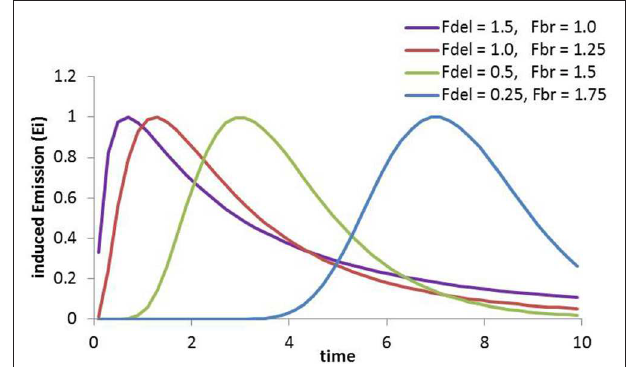
FIGURE 1 | Sensitivity of the Fraser-Suzuki function to changes in the parameters. The unit of time is not specific but a reasonable order of magnitude would be hours for the distributions